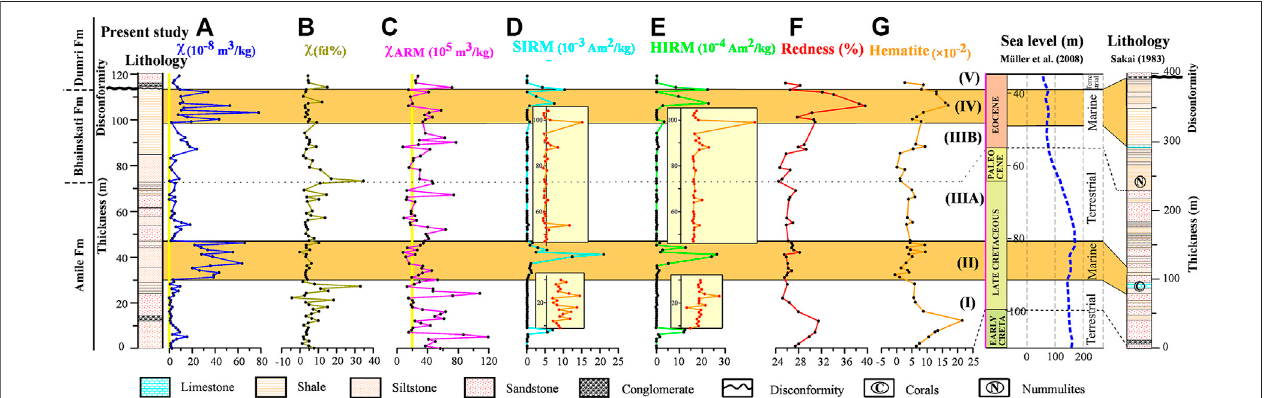
FIGURE 3 | (A-G) Lithology, χ , χ fd%, χ ARM, SIRM, HIRM, redness (%) and diffuse re fl ectance spectroscopy-determined hematite content (FDV568 nm), and ( H ) Their comparison with global sea level (Müller et al., 2008) and correlation for the Palpa section, modi fi ed after Sakai (1983). The zones I (0 – 30 m), IIIA (47 – 72 m), and V (114 – 120 m) are de fi ned as terrestrial deposits and zones II (31 – 46 m), IIIB (73 – 98 m) and IV (99 – 113 m) as marine deposits. Note that the orange color represents marine and white represents the terrestrial environment.